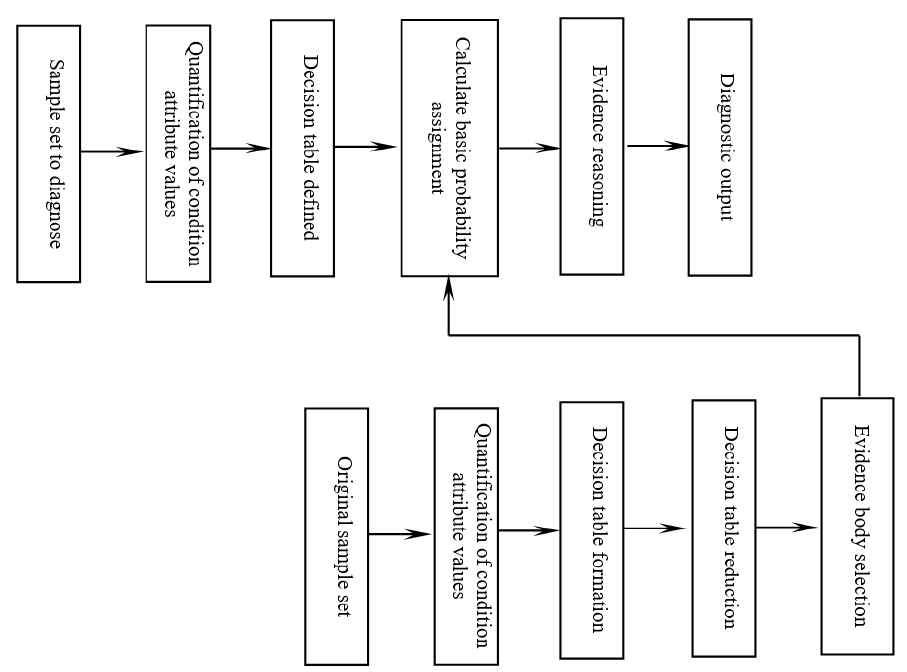
Fig. 1 Structure of diagnostic model integrated with evidence theory and rough